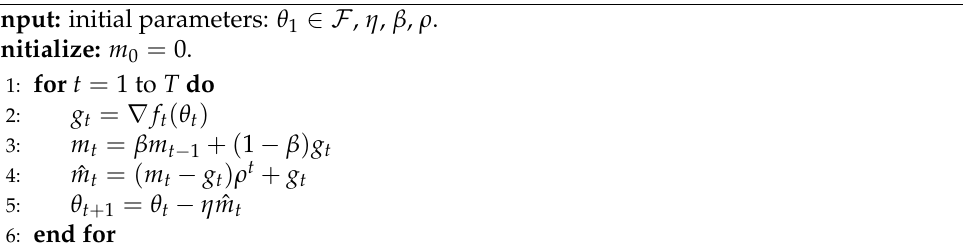
Algorithm 1 A Scaling T ransition method from SGDM to SGD